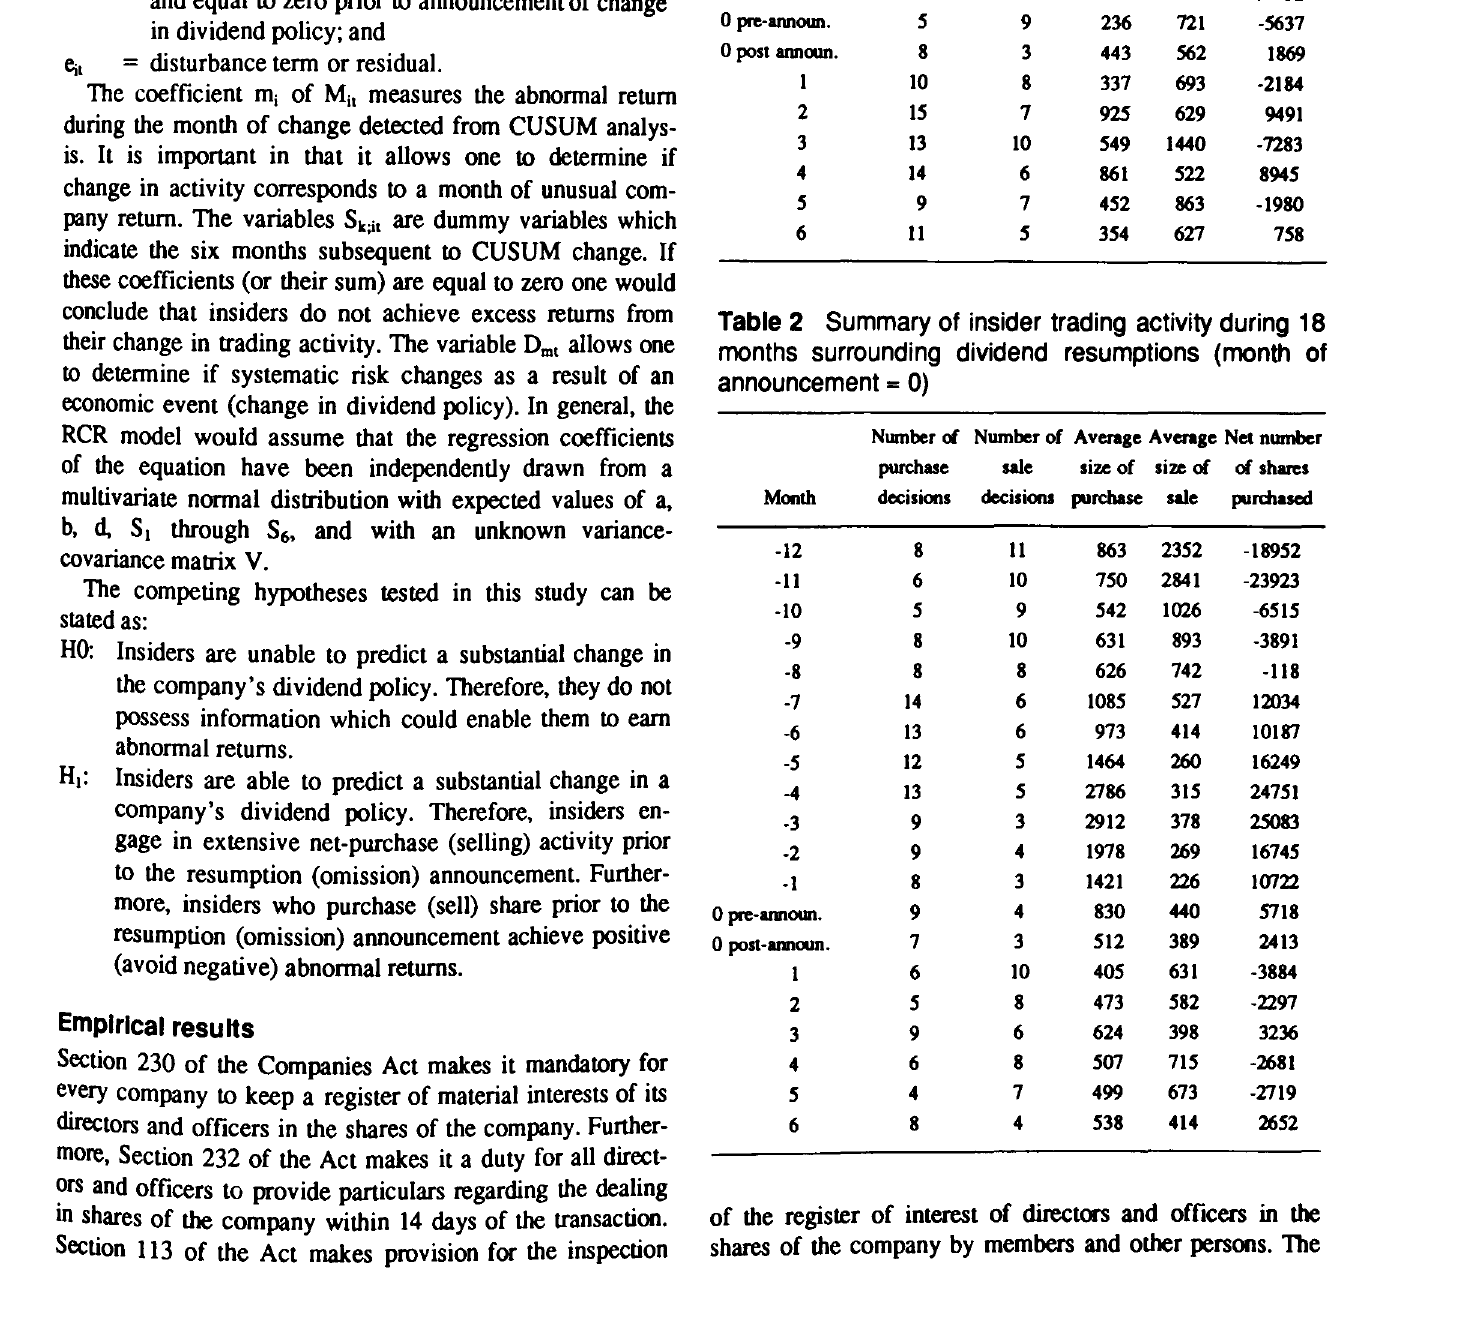
Table 2 Summary of insider trading activity during